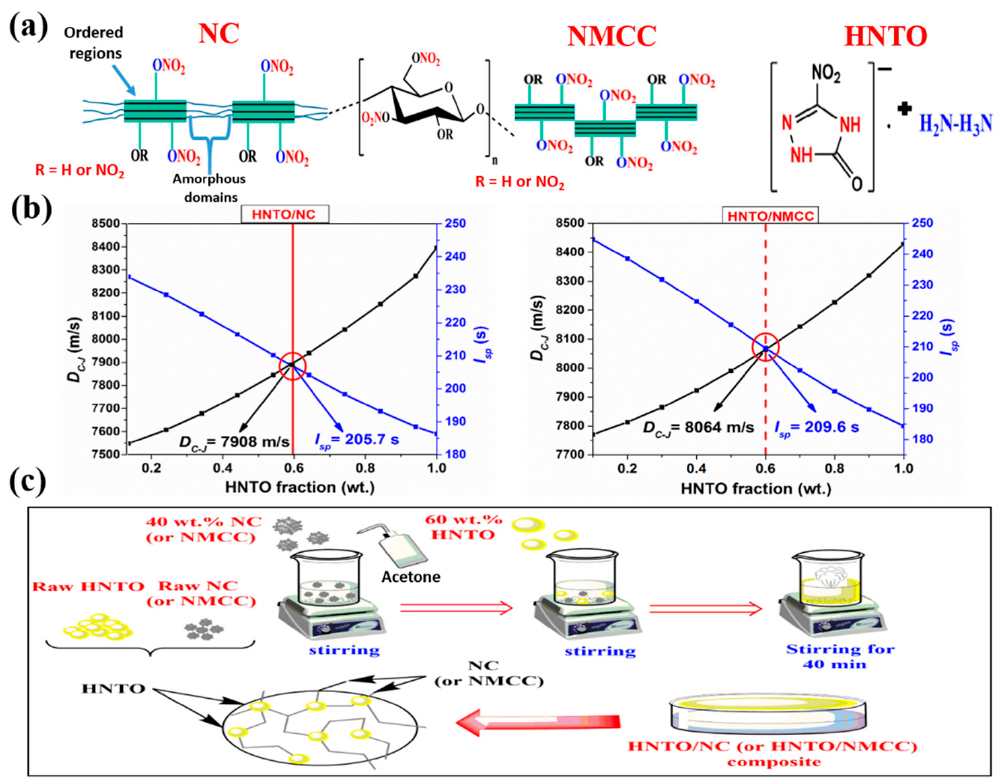
Figure 8. ( a ) Molecular structures of pure NC, NMCC, and HNTO; ( b ) evolution of the specific impulse and detonation velocity of the prepared composites as a function of the HNTO weight percentage; ( c ) preparation procedure of the target energetic